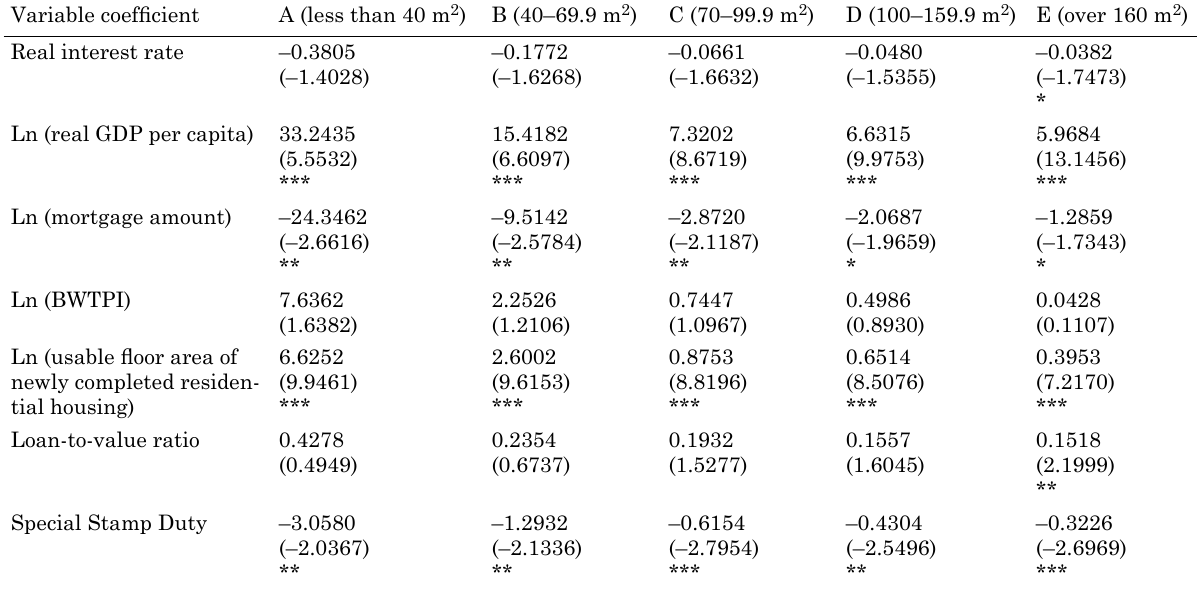
Table 5. The cointegrating coefficients for individual property submarket indices Variable